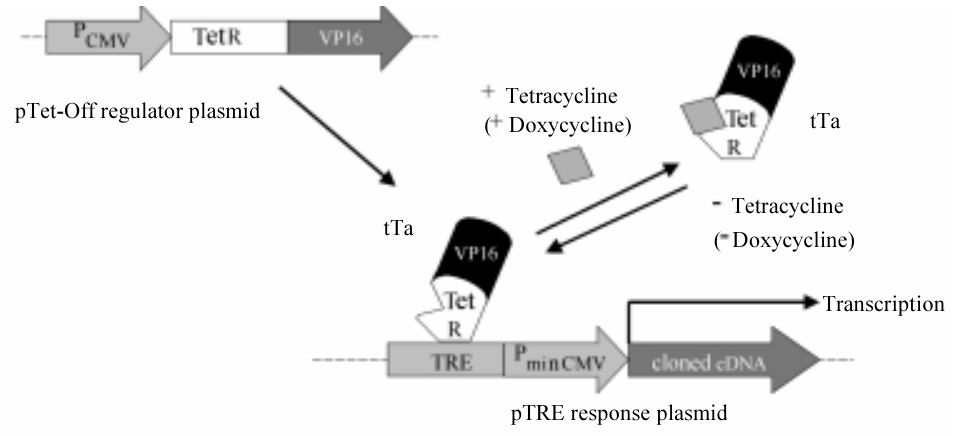
Figure 2 - Schematic presenta- tion of the Tet-Off expression system. The tetracycline-con- trolled transactivator (tTa), that is a fusion of the TetR repressor with the activation domain of VP16, is constitutively produced from the cytomegalovirus pro- moter (P CMV ) by the regulator plasmid. In the absence of tetra- cycline, tTa binds the tetracy- cline response elements (TRE) upstream from the minimun CMV promoter (P minCMV ) in the response plasmid, activating transcription of the cDNA. When tetracycline or doxycycline is added to the medium, it binds to tTa, which, in turn, releases the TRE, stopping